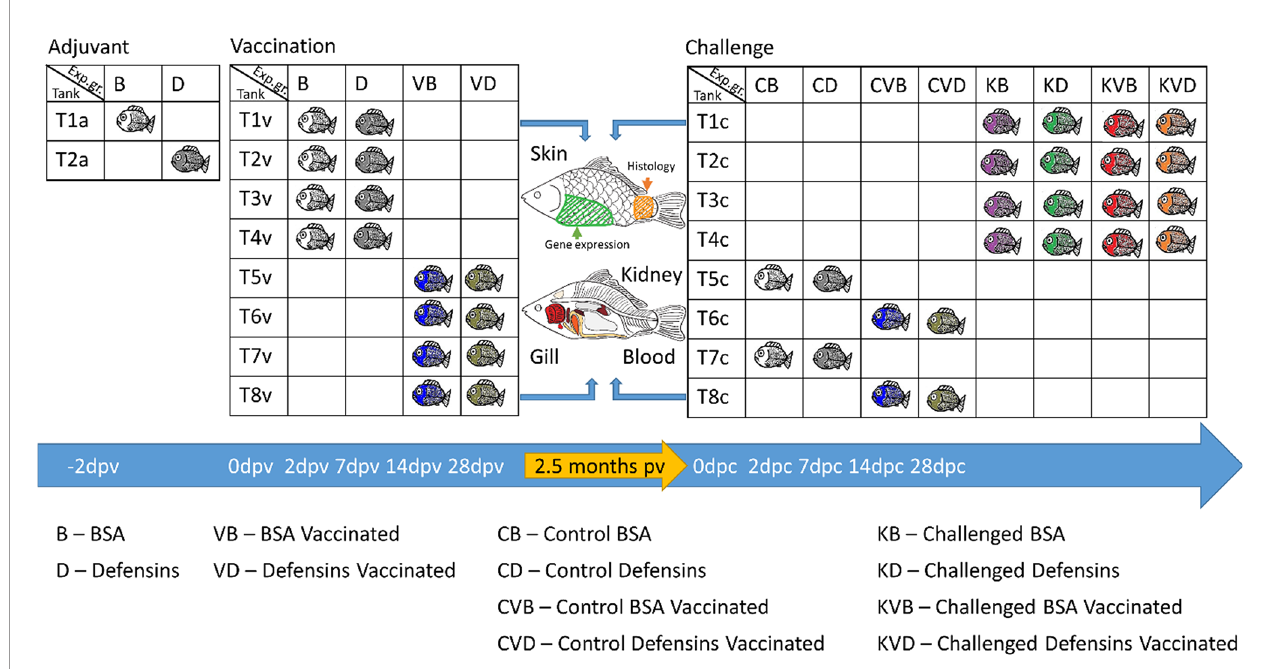
FIGURE 1 | Schematic presentation of the tanks and experimental groups and samples collected from the fi sh used in this